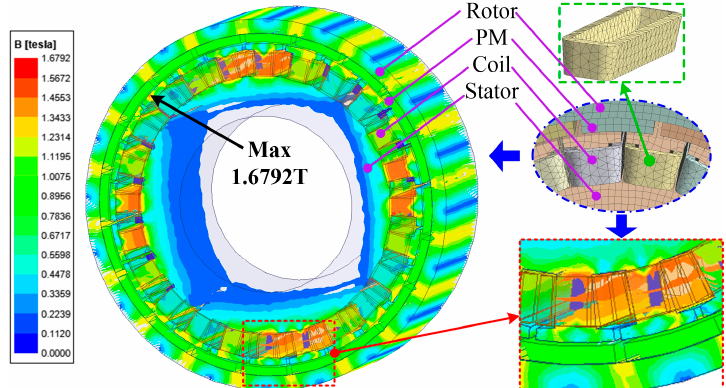
Figure 3. Magnetic flux density distribution contour of PM-IWM under on-load condition.